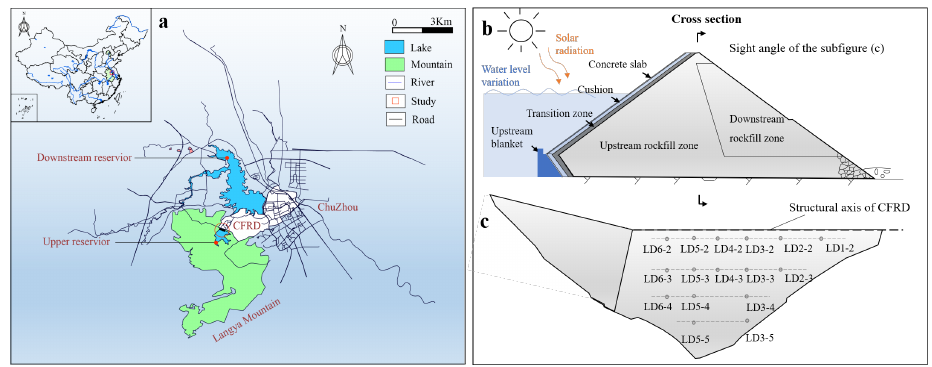
Figure 5. Schematic of: ( a ) location, ( b ) structure, ( c ) distribution of monitoring points of settlement, of the CFRD for Langyashan